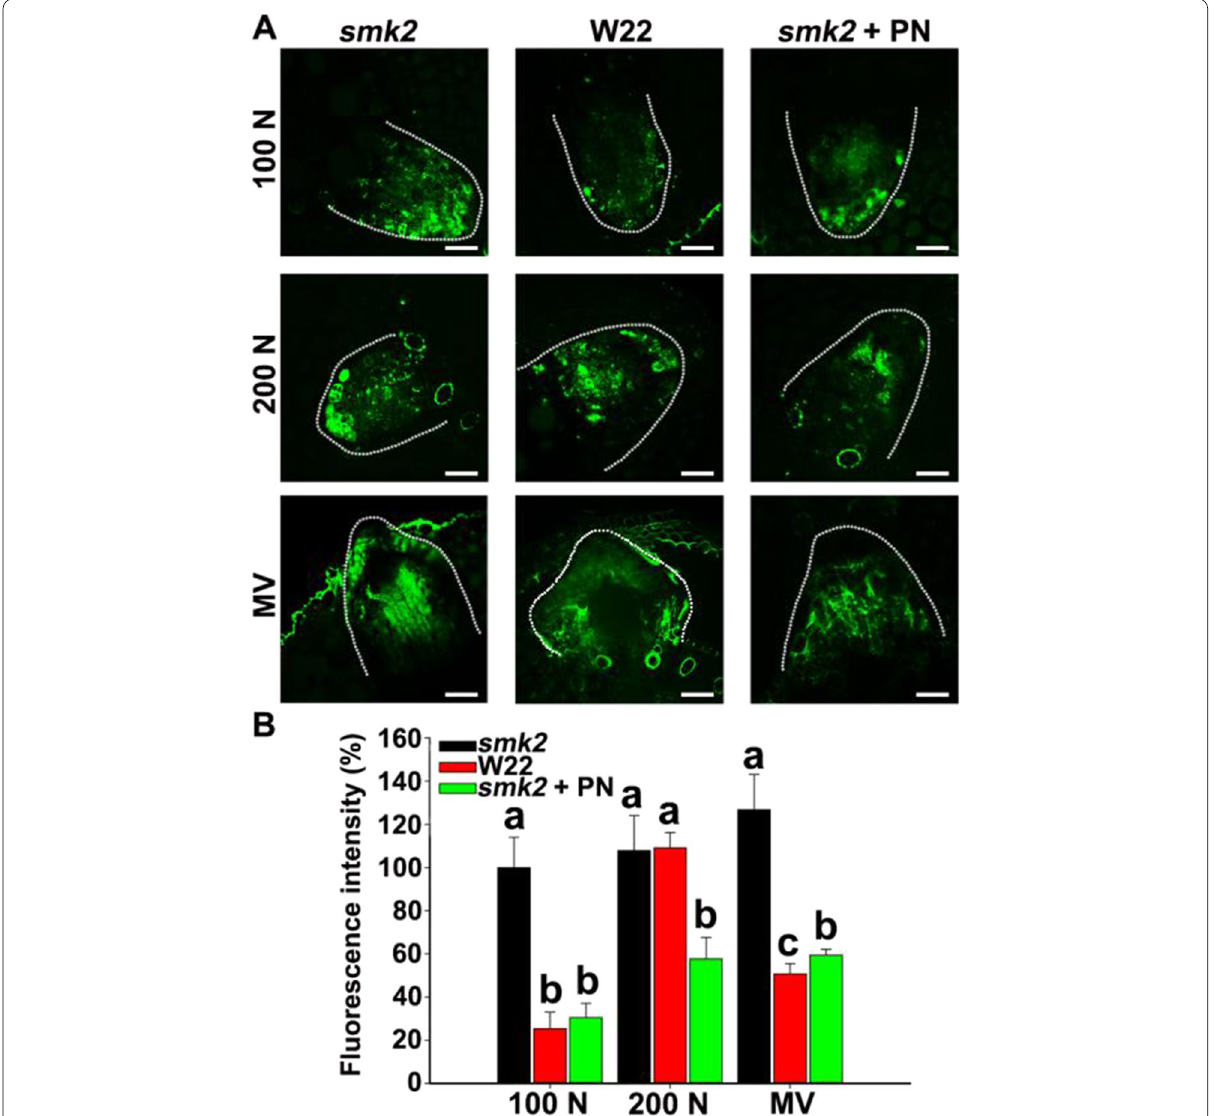
Fig. 5 PN is extremely essential for smk2 heterozygous plants to scavenge excessive ROS induced by NaCl and MV. A ROS fluorescence in LRs of 6-d-old smk2 heterozygous and W22 seedlings subjected to 100 mM NaCl (N), 200 mM NaCl, 10 μM MV (methyl viologen) or added with 100 μM PN treatments for 24 h by using the fluorescent dye H 2 DCFDA. Bar 50 μm. The white thread represents the profile of the LR. B ROS fluorescence = intensity of (A). Image J software was used for quantifying fluorescence intensity. The different letters represent significant differences ( P <